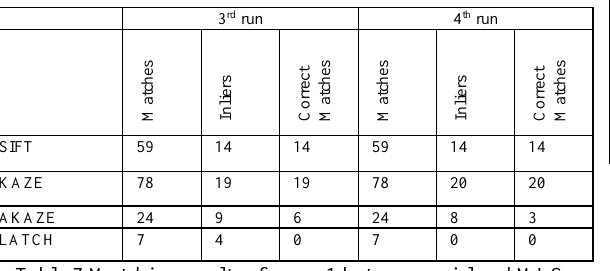
Table 7 Matching results of scene 1 between aerial and MLS ortho-image of the 3 rd and 4 th iteration